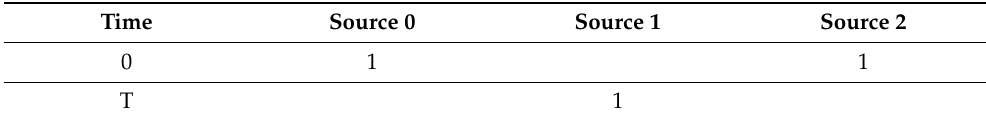
Figure 13. Topology 3. Table 8. Packet generation scenario in topology 3.